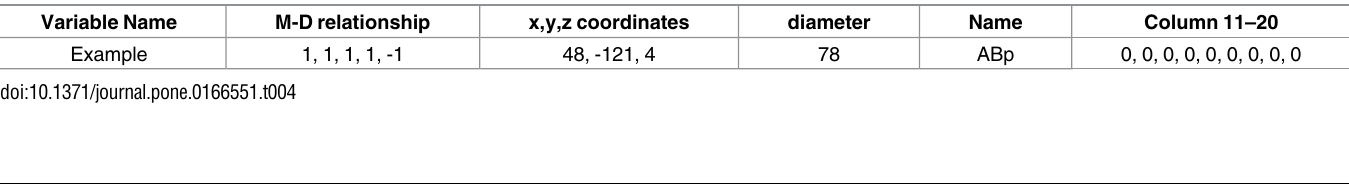
Table 4. Example of output data format.